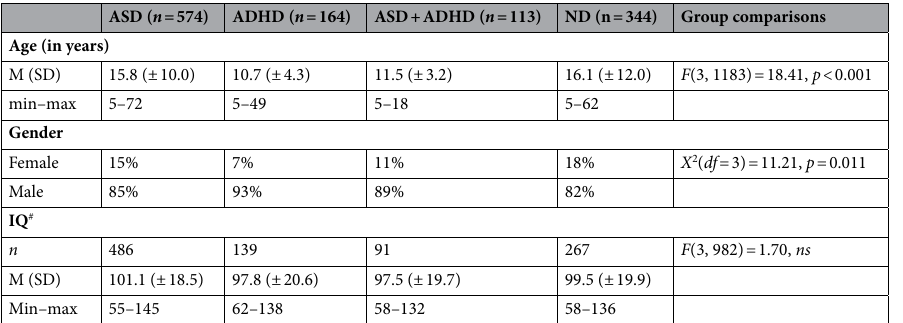
Table 3. Main sample demographics. ASD autism spectrum disorder, ADHD attention-deficit/hyperactivity disorder, ASD + ADHD co-occurrence of both diagnoses, ND no psychiatric diagnosis, N/A not applicable, ns not significant; # Considering solely an IQ criterion of < 70 as a cut-off for Intellectual Disability (ID), there was the following proportion of ID per group: ADHD (1.9%), ASD (2.2%), ASD + ADHD (4.3%), and ND (4.7%), with no significant differences between groups (p =